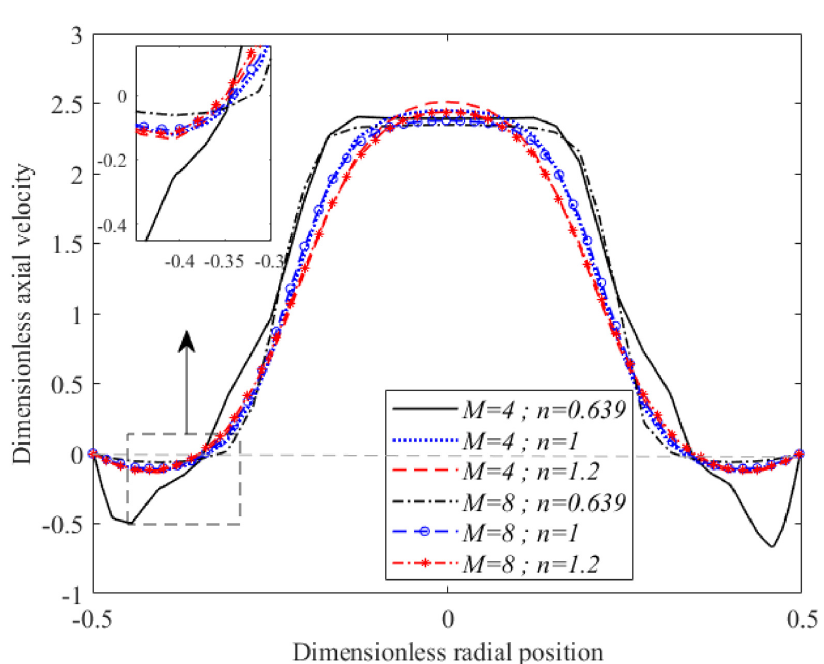
Fig 6. Variation of axial velocity at x = 1.5 with different in Hartmann number and fluid characterisation (Re = 300 and τ = 0.4 a m